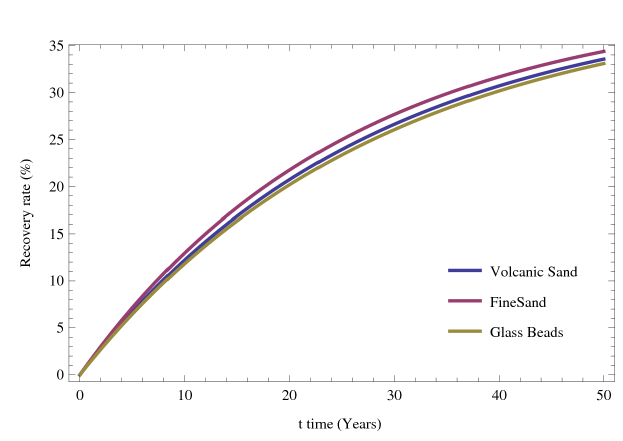
Fig. 8: Recovery rate in fractured porous medium without effect of magnetic